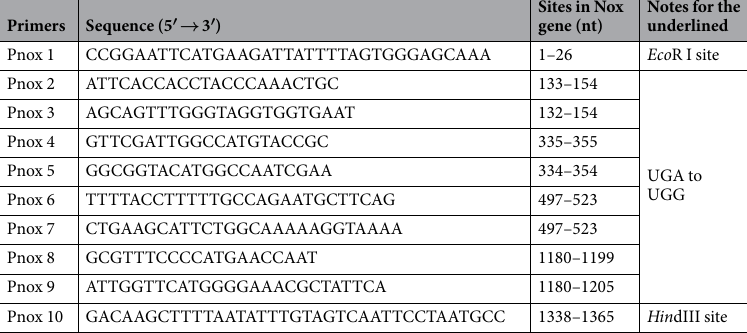
Table 1. Oligonucleotide primers used for amplification and site-directed mutagenesis of NOX gene.